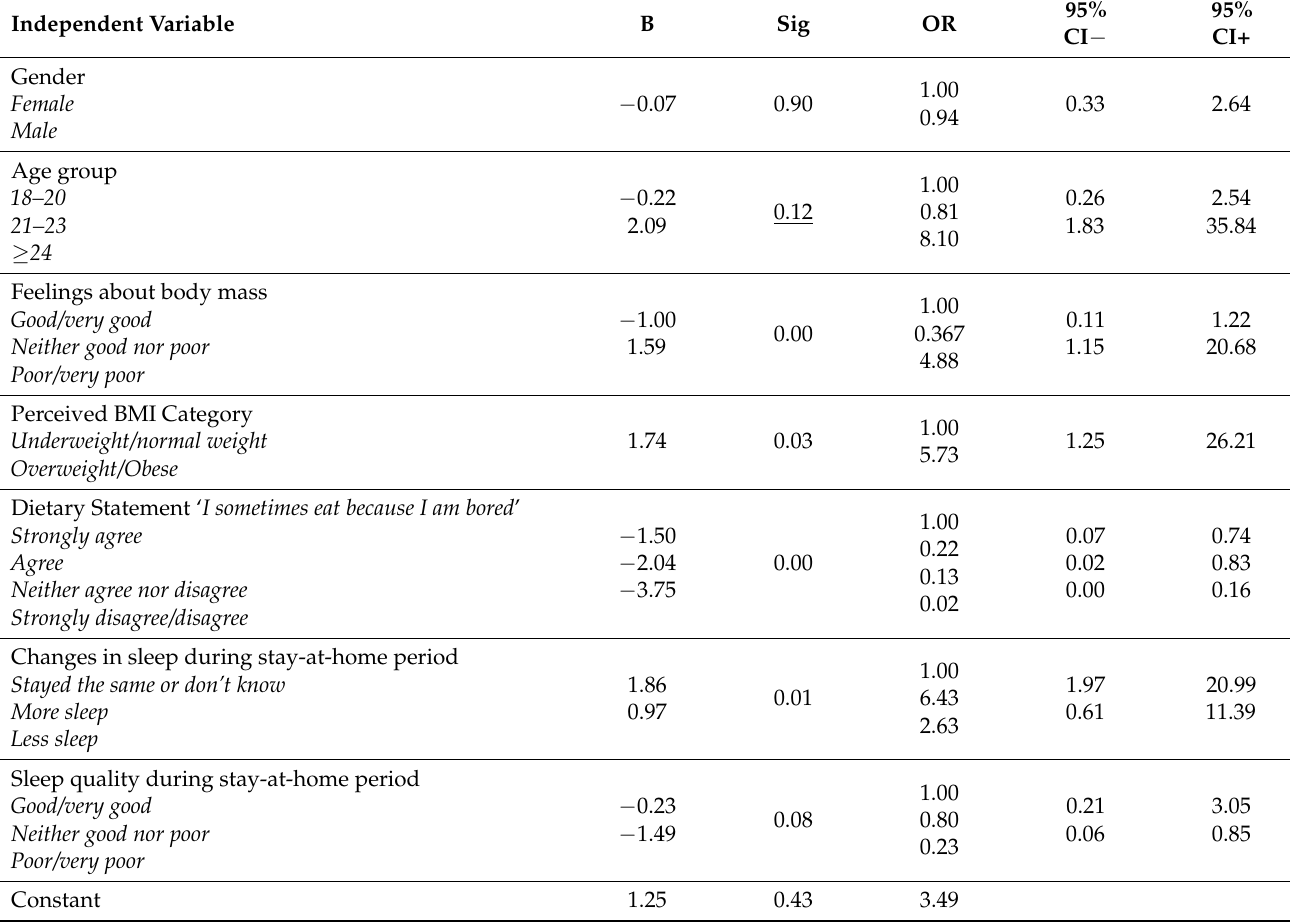
Table 5. Logistic Regression predicting the likelihood of participants’ self-reported body mass gain during the COVID-19 pandemic (n = 178). Underline indicates a low level of significance ( p >